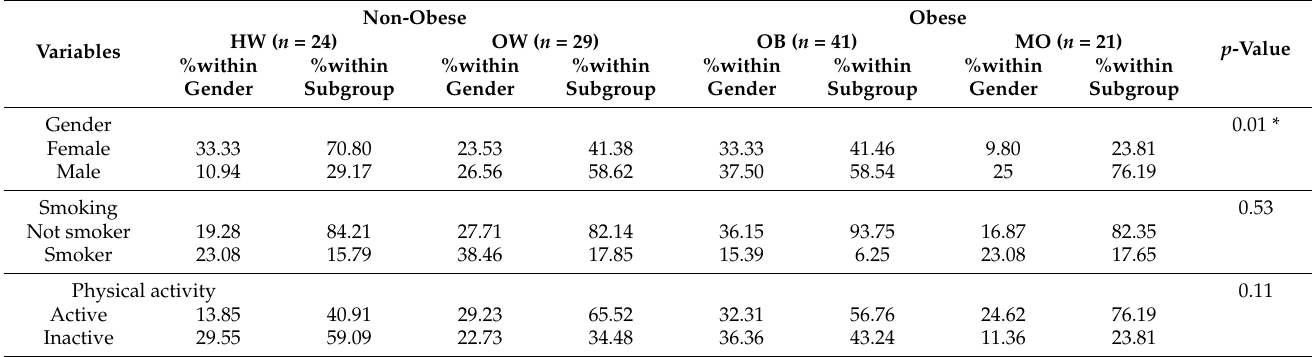
Table 1. Demographic characteristics of participants stratified by subgroups, n =